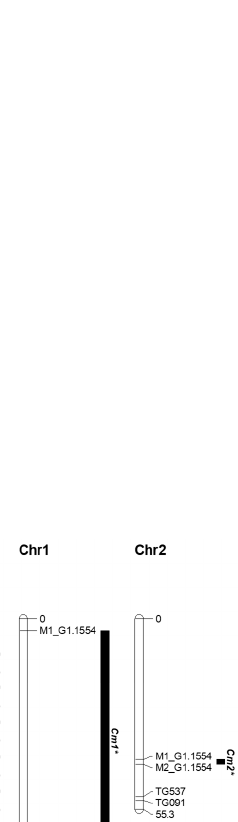
di ff erentiation [32]. Mutations in the Arabidopsis CYP90C1 gene have been shown to result in dwarf phenotypes, as well as to a ff ect the expansion of cells in the stems of mutants and the arrangement of pith cells [29].